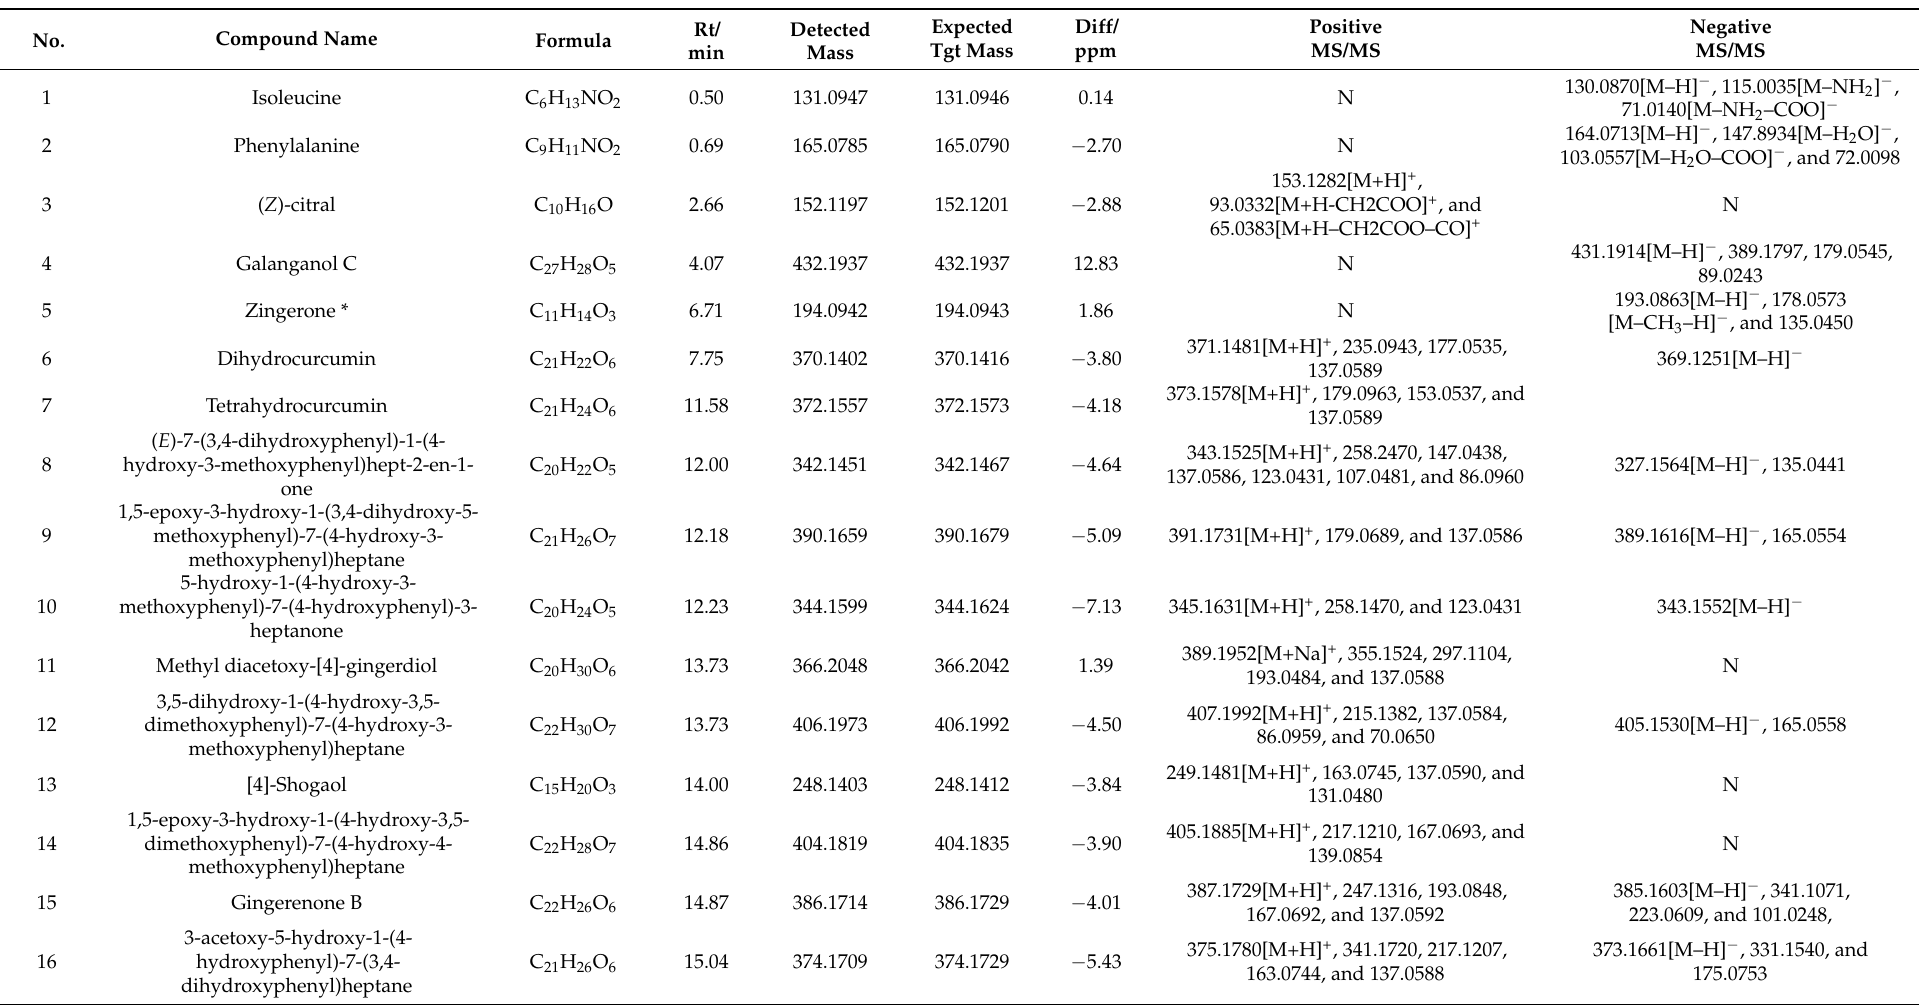
Table 1. UHPLC–ESI–QTOF–MS/MS results of the analysis of the dried ginger extract in the positive and negative